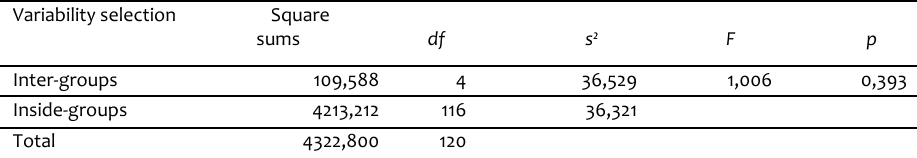
Table No. 6. Analysis of variances scores achieved by the teachers depending on the years of work experience at the scale established for assessment of the